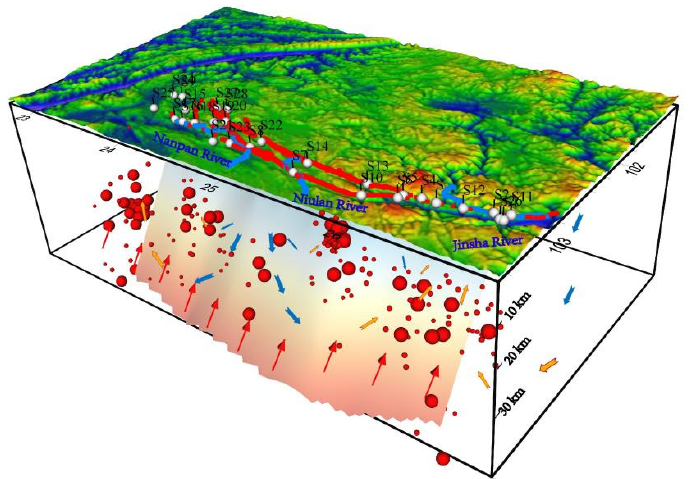
Figure 9. Conceptual model of the origin of groundwater and the hydrogeochemical cycling process in the XJF.